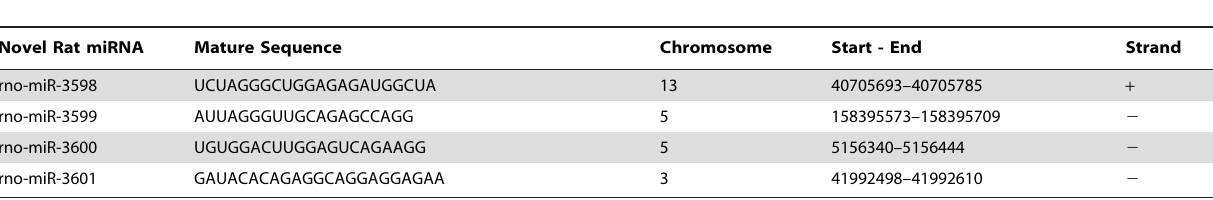
Table 5. Four rat-specific novel miRNAs - Mature sequences and genome locations.